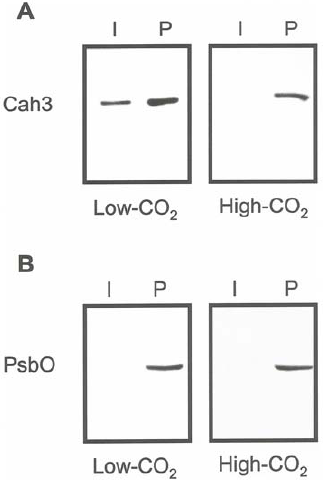
Figure 7. Differential extraction of Cah3 polypeptide from PSII core complexes isolated from C.reinhardtii cells grown under high-CO 2 (A) or acclimated to low CO 2 conditions for 4 h (B). PSII hydrophobic and hydrophilic proteins were extracted from PSII core complexes using a chloroform/methanol (2:1, v/v) mixture (see Materials and Methods). Immunoblot analysis of integral (I) and peripheral (P) protein fractions from PSII core complexes were probed with antibodies against Cah3 (Cah3) and PsbO protein (PsbO). The lanes were loaded with 10 m g protein.